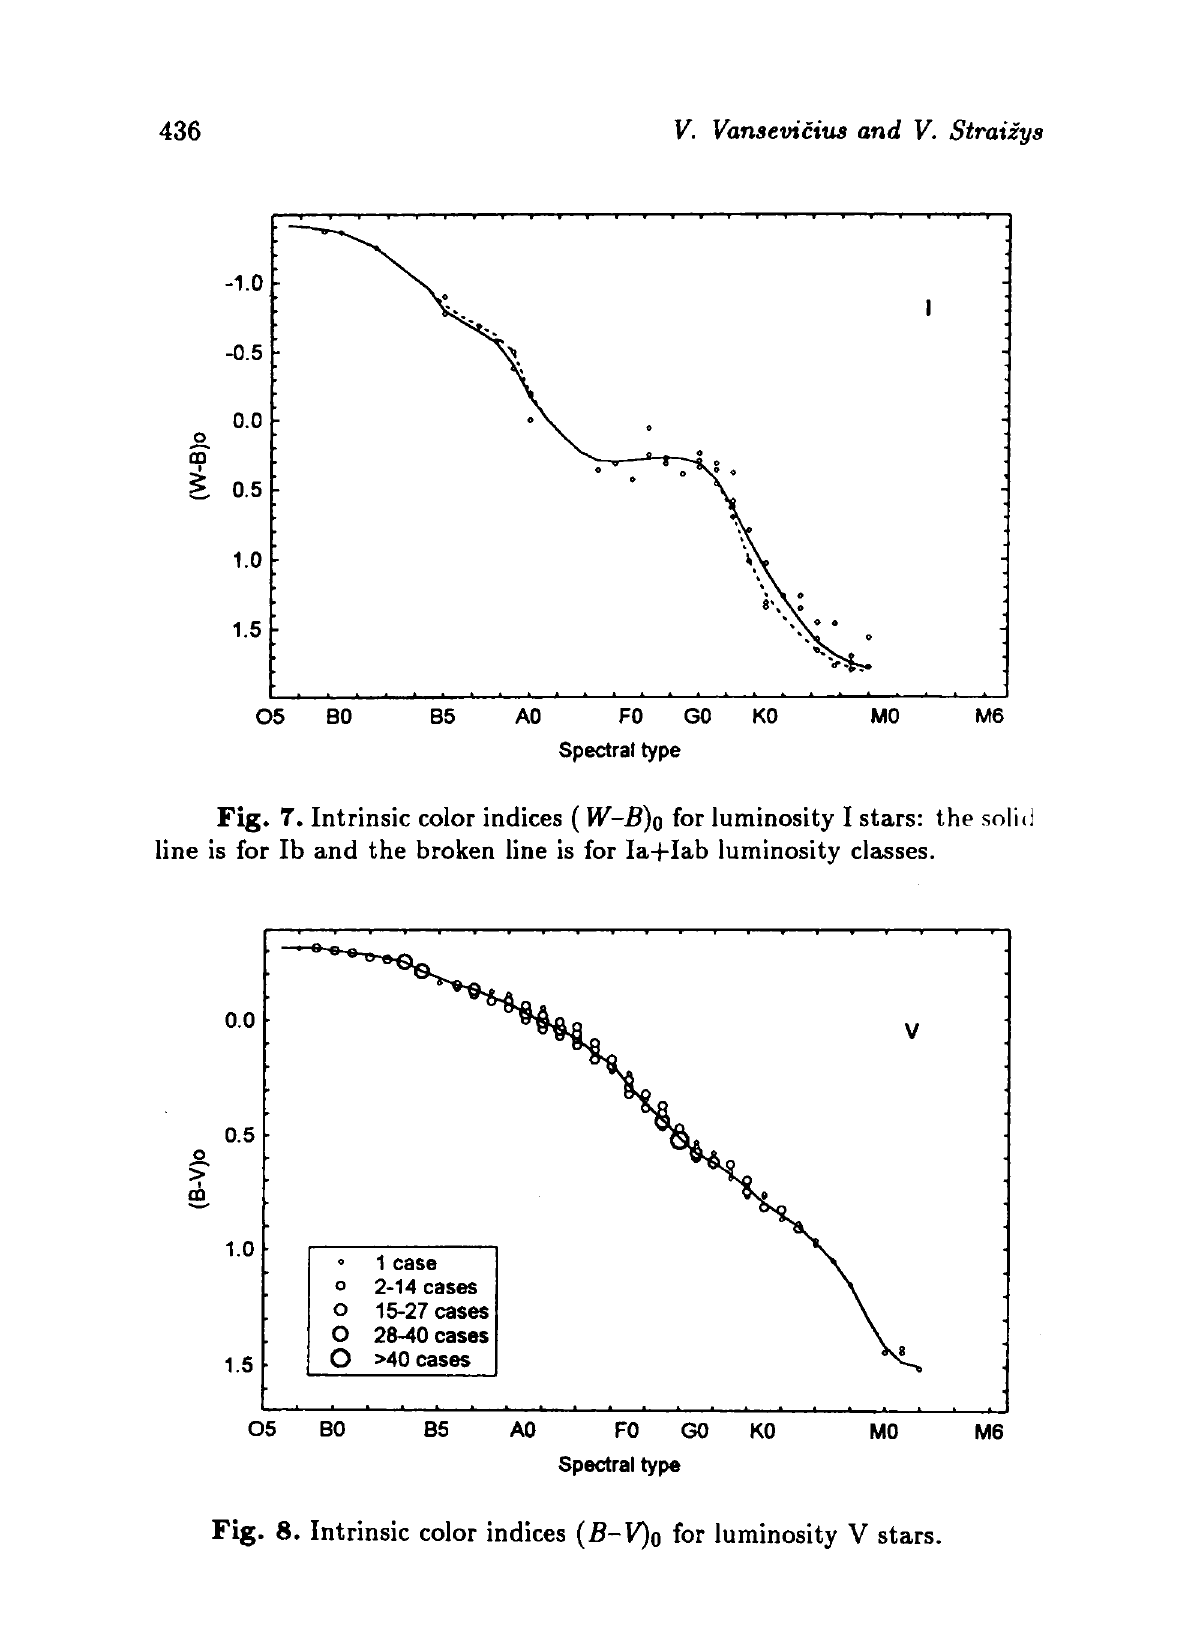
Fig. 8. Intrinsic color indices (B-V)o for luminosity V